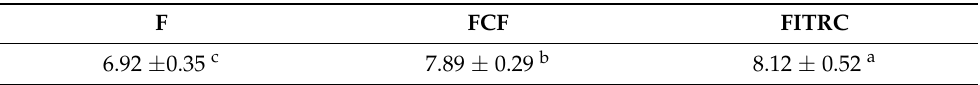
Table 5. Preliminary sensory evaluation of white brined cheese produced with no starter culture, with free L. paracasei SP5 and with immobilized L. paracasei SP5 on